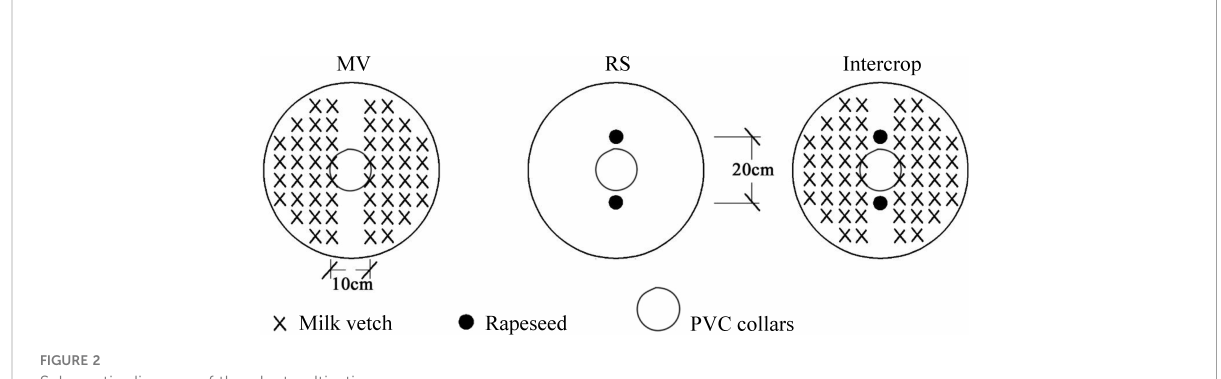
FIGURE 2 Schematic diagram of the plant cultivation.